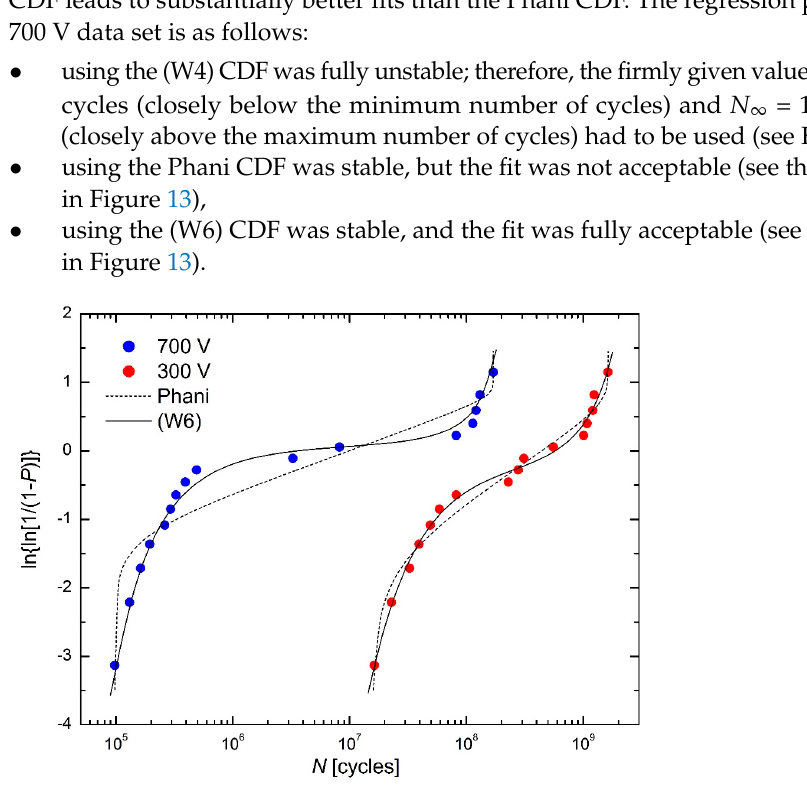
Figure 13. Weibull plots of the numbers of cycles to the destruction of the multilayer ceramic piezoelectric actuators at the temperature of 90 ◦ C for given AC biases [11] for the 5-parameter Phani modification (dashed lines) and 6-parameter (W6) modification (solid lines).